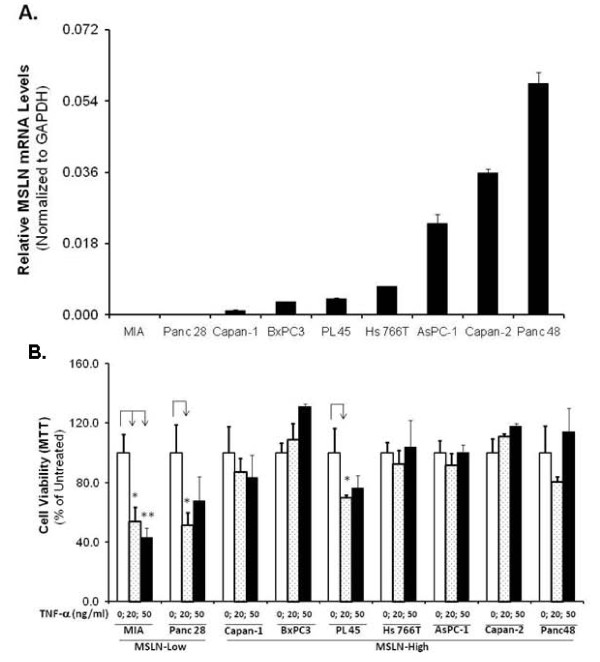
MSLN expression level positively correlates with protection of pancreatic cancer cell lines from TNF-α induced apoptosis. (A). Evaluation of MSLN mRNA expression in PC cell lines. Relative MSLN mRNA levels in pancreatic cancer cell lines MIA PaCa-2, Panc28, Capan-1, BxPC3, PL 45, Hs 766T, AsPC-1, Capan-2 and Panc 48 cells. Total mRNA from the cell lines were reverse transcribed and tested for MSLN expression by Real Time PCR. The results depicted denote MSLN mRNA levels in each cell line normalized to the GAPDH mRNA level. Relative mRNA level is presented as 2^[Ct(GAPDH)-Ct(MSLN)]. The bars denote SD of duplicate data. (B). A panel of PC cells' viability with or without TNF-α treatment. Cells were seeded in 96-well plates, serum-starved for 24 h, and then cultured in serum free medium ± 20/50 ng/ml of TNF-α for 72 h. Viable cells were quantitated by using MTT assay. Relative fold increase in viability is plotted along Y axis. Data plotted show means of triplicate wells.